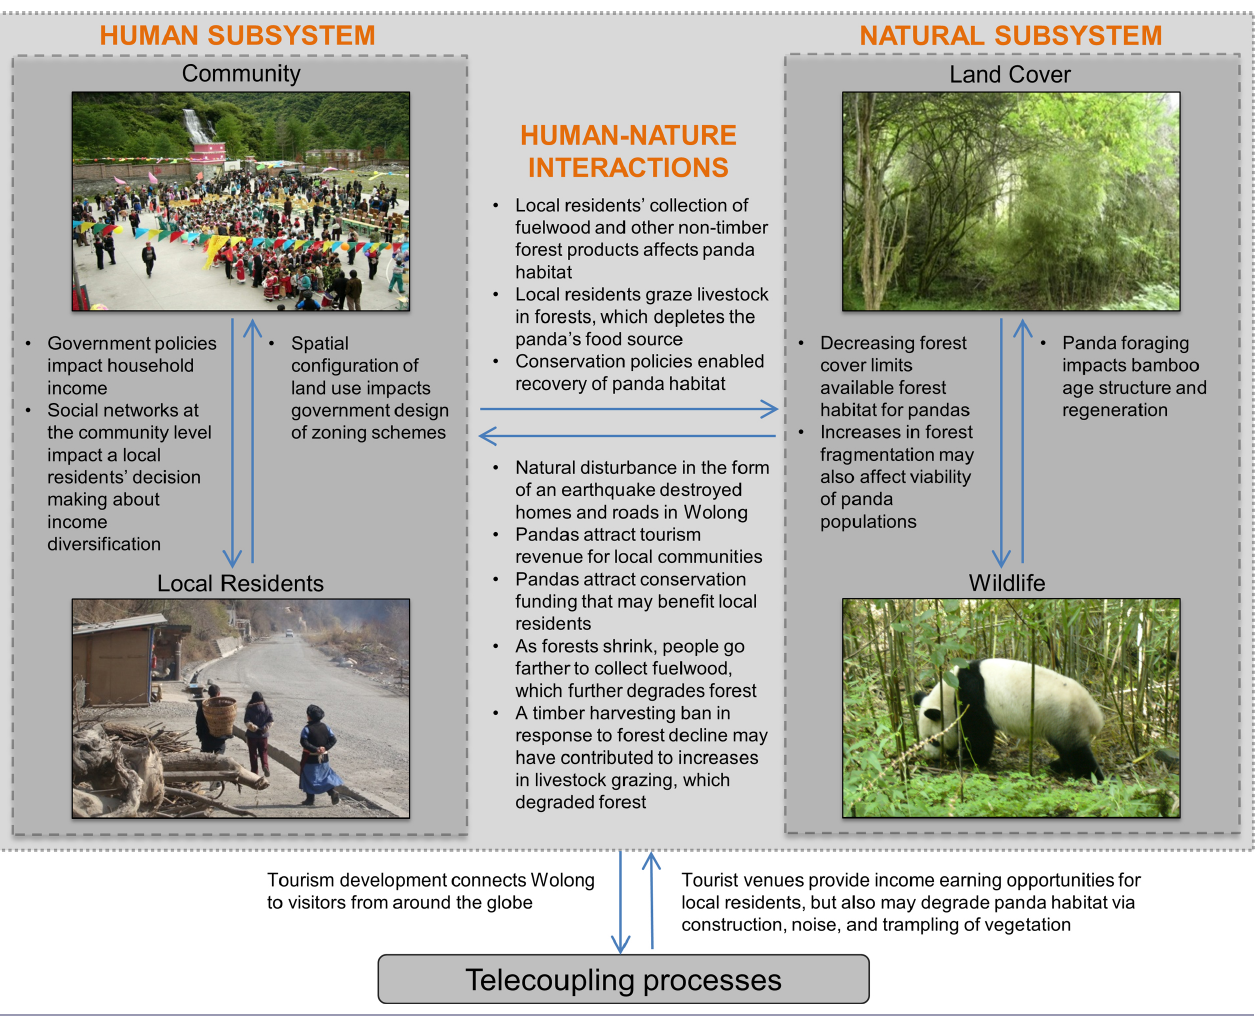
Fig. 4. Illustration of relationships within the human and natural subsystems as well as human-nature interactions that are important to understanding and conserving giant pandas in Wolong Nature Reserve, China. Relations are shown using a general coupled human and natural systems (CHANS) framework (see Fig. 1), and are not exhaustive or constant over time and across space. We encourage future research and conservation efforts to use this CHANS approach to continue filling in important information gaps in this and other sites where people and wildlife interact in complex